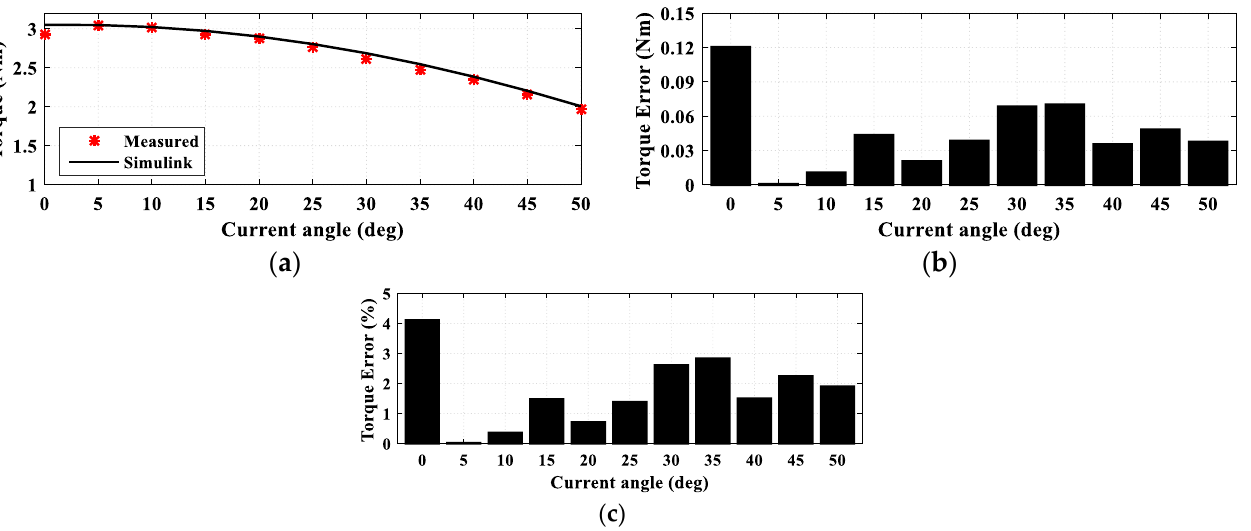
Figure 18. Comparison between the measured and simulated torque vs. current angle: ( a ) measured and simulated torques vs. current angle; ( b ) torque error in Nm; ( c ) percentage torque error.